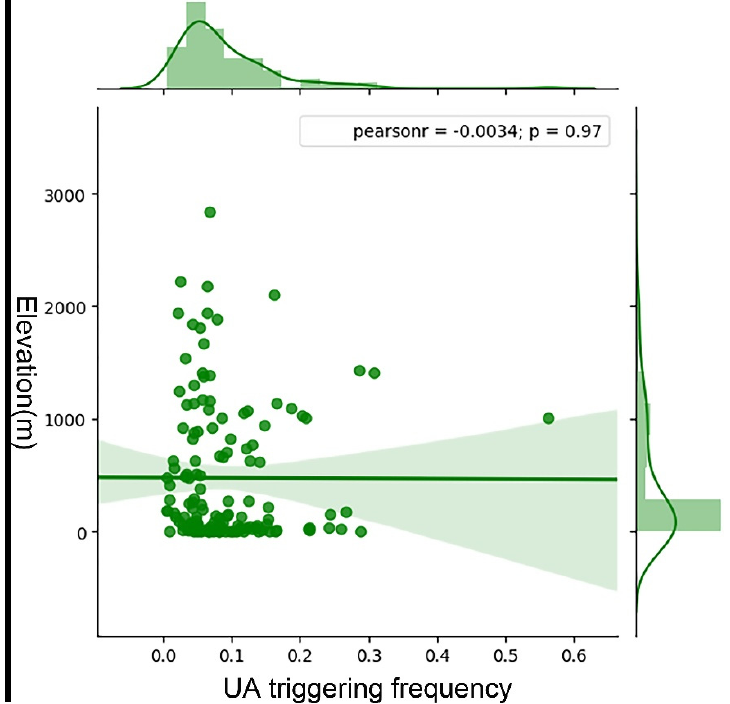
Figure 5. Correlation between UA triggering frequency (Boeing aircraft) and elevation.